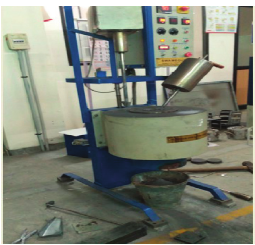
Figure 1: Stir casting setup.